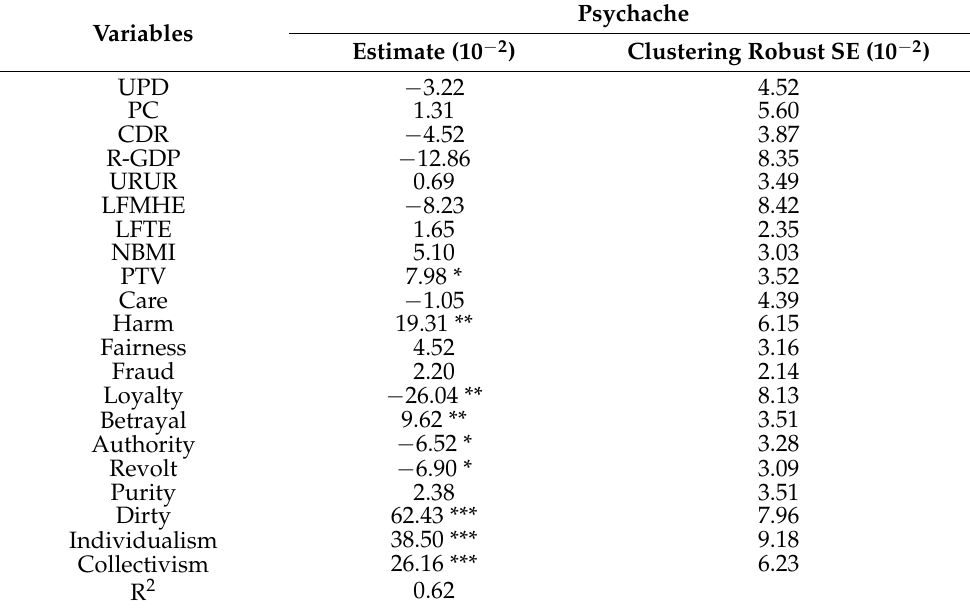
Table 4. Regression outcomes of two-way FE model of clustering robust standard errors.